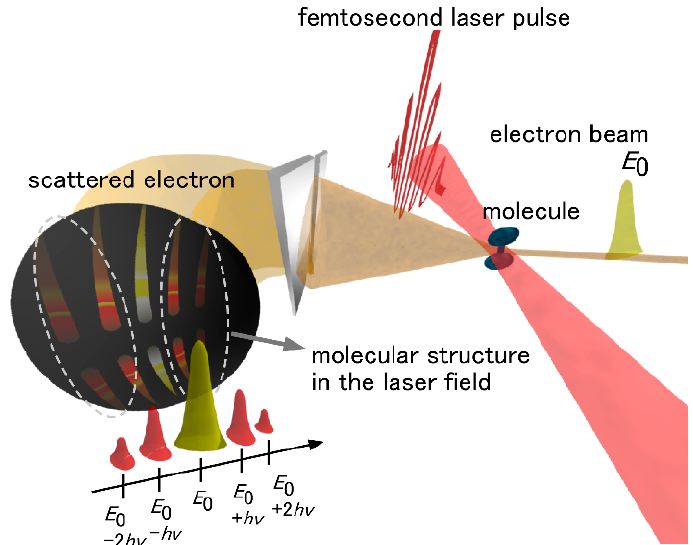
Figure 10. The schematic of the laser-assisted electron diffraction method [81]. Reprinted by